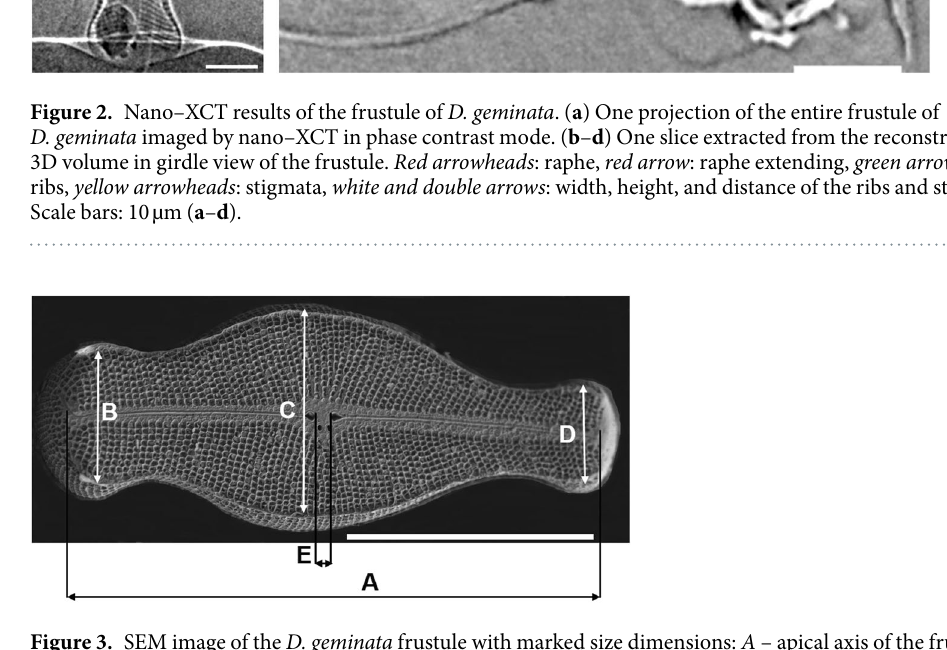
Figure 3. SEM image of the D. geminata frustule with marked size dimensions: A – apical axis of the frustule; B through D – transapical axis. Scale bar: 40 µ m.